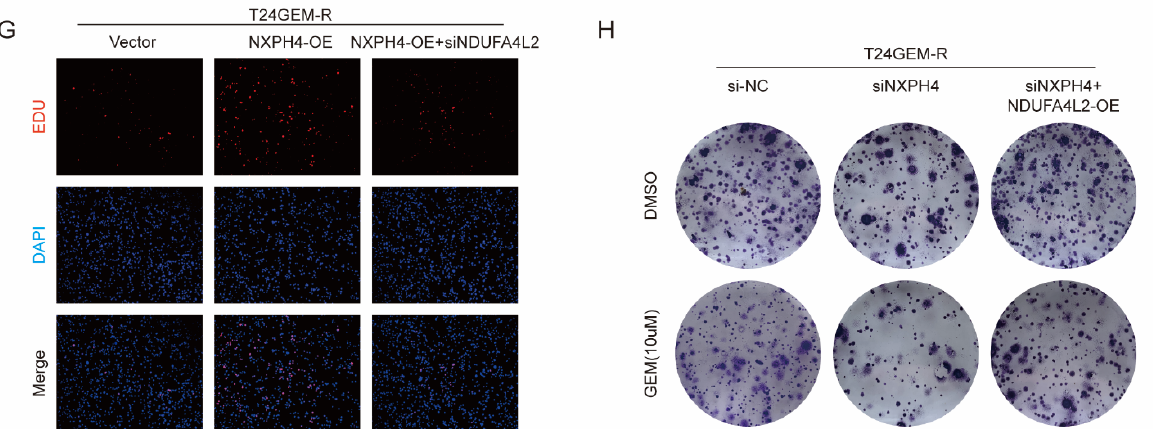
Figure 8. NXPH4 promotes ROS production and glycolysis-dependent gemcitabine resistance by regulating NDUFA4L2. ( A ) Western blot of NDUFA4L2 in T24 parental and gemcitabineresistant cell lines. ( B , C ) Cells were transfected with siNXPH4 or NXPH4 plasmid, followed by siNDUFA4L2